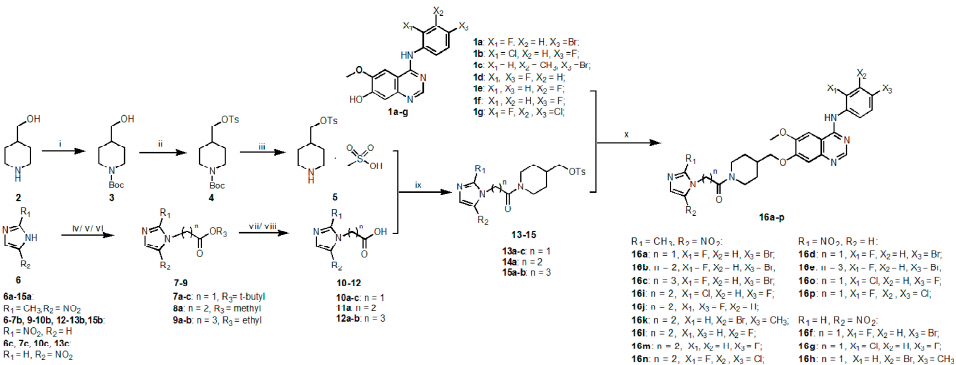
Figure 2. The docked poses of compound 16f (C: yellow; N: blue; O: red) or vandetanib (C: green; N: blue; O: red) at the ATP binding cleft of EGFR kinase ( A ), and VEGFR-2 kinase ( B ).